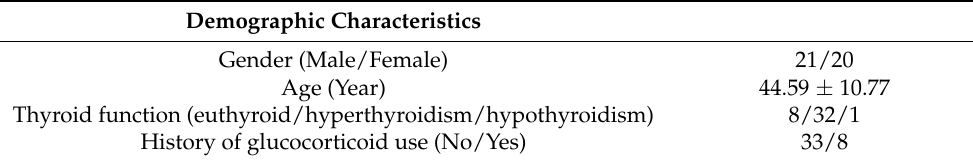
Table 1. Demographic characteristics of TAO patients.